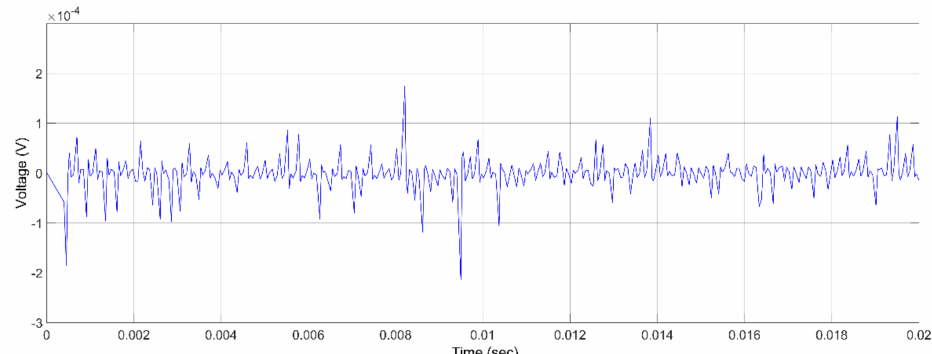
Figure 16. PD at 10 kV-Half Radius.